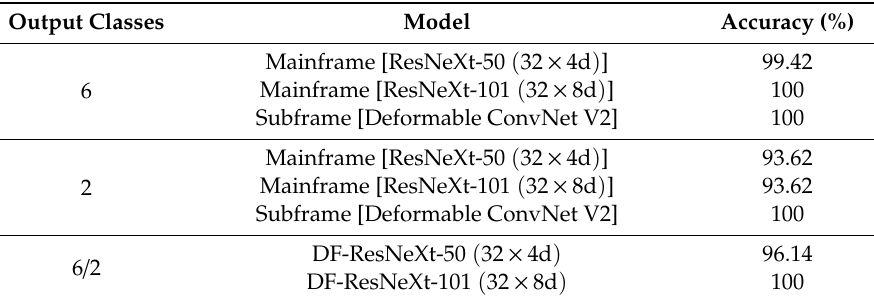
Table 4. Experimental results for the